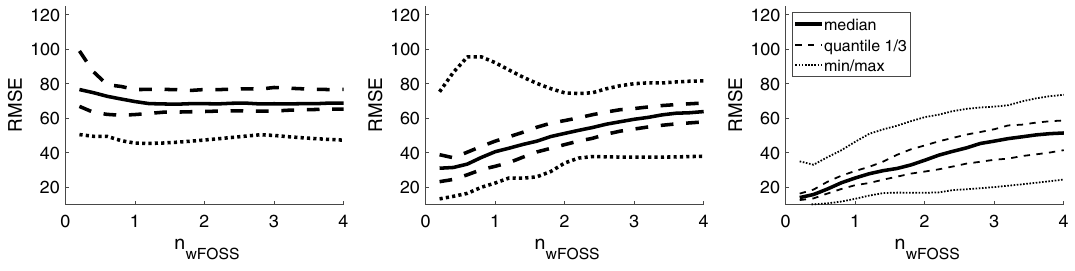
Fig. 7 Branin function: Curves of the RMSE of 100 FOSS sampling plans as a function of the FOSS exponent n wFOSS for the RBF model with 4 (left), 9 (center), and 16 (right) sampling points